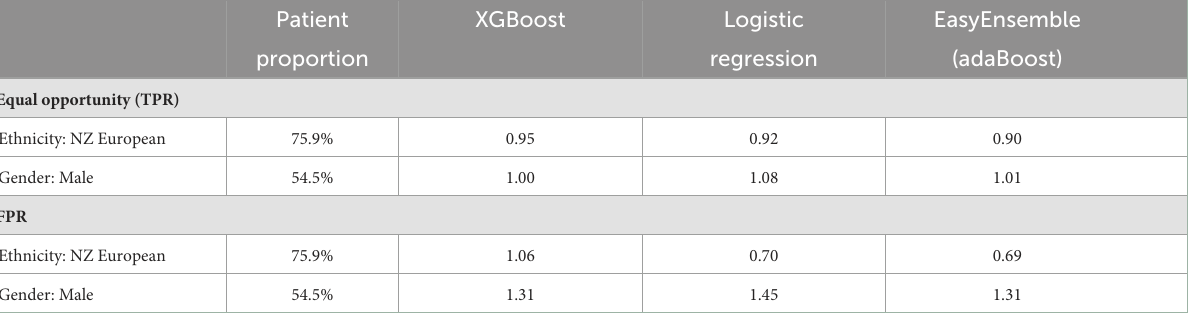
TABLE 6 NZ-GP Harms data.